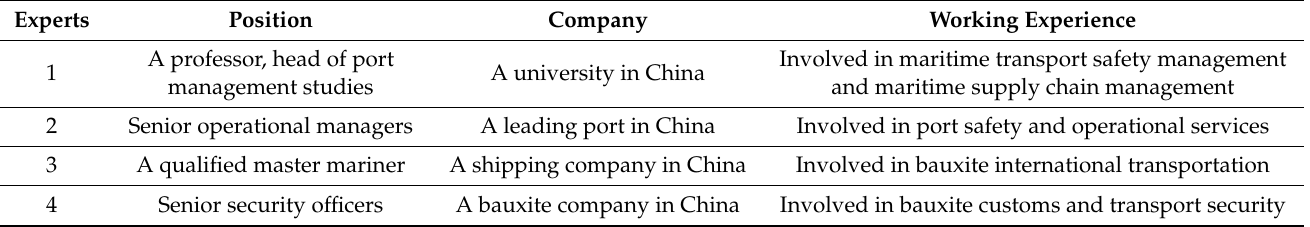
Table 1. Experts’ knowledge and experience.